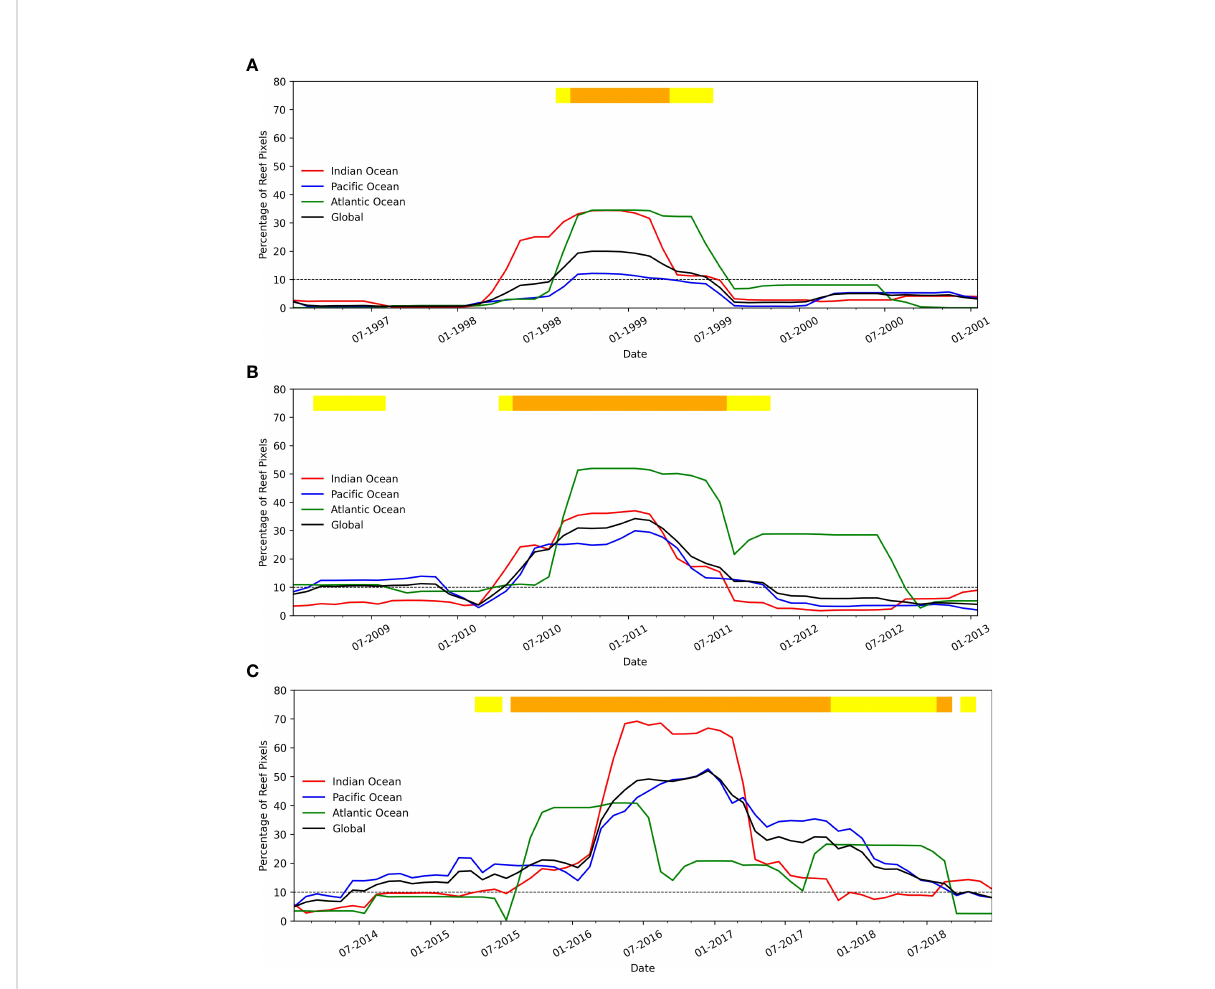
FIGURE 6 As for Figure 3 using an 8-month detection window applied to the 5-km CoralTemp dataset for the periods encompassing (A) the fi rst global coral bleaching event (GCBE1) in 1998; (B) GCBE2 in 2010; and (C) GCBE3 in